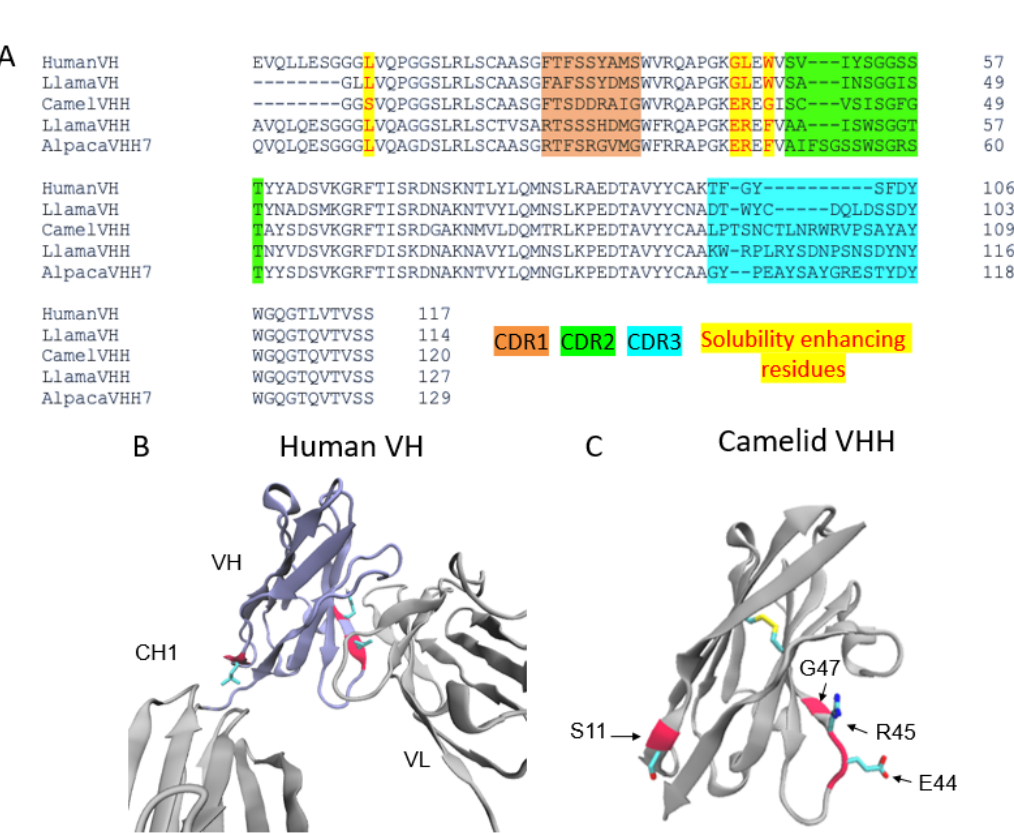
Figure 2. Architecture of VHHs promotes their solubility and stability. ( A ) Multiple sequence alignment of the Human VH, Llama VH, Llama VHH, Camel VHH, and Alpaca VHH domains. CDR regions are highlighted orange (CDR1), green (CDR2), and blue (CDR3). The VHH domains shown have a larger CDR3 region than the VH CDR3s. Highlighted in yellow and written in red are residues mutated to enhance solubility in VHH domains. Camel VHH bear four mutations (L11S, G44E, L45R, and W47G). Llama and alpaca VHHs bear G44E, L45R, as well as a W47F mutation. ( B ) Crystal structure (PDB ID 1IGY) of a human antibody with the VH domain colored in purple. Residues mutated in the camelid VHH domains are colored red. L11 makes contact with the CH1 domain while L45 and W47 form contacts with the VL domain. ( C ) Crystal structure of a camelid (camel) VHH (PDB ID 6U14). E44, R45, and G47 in the hypothetical VL binding site promote stability and solubility of the VHH as a single